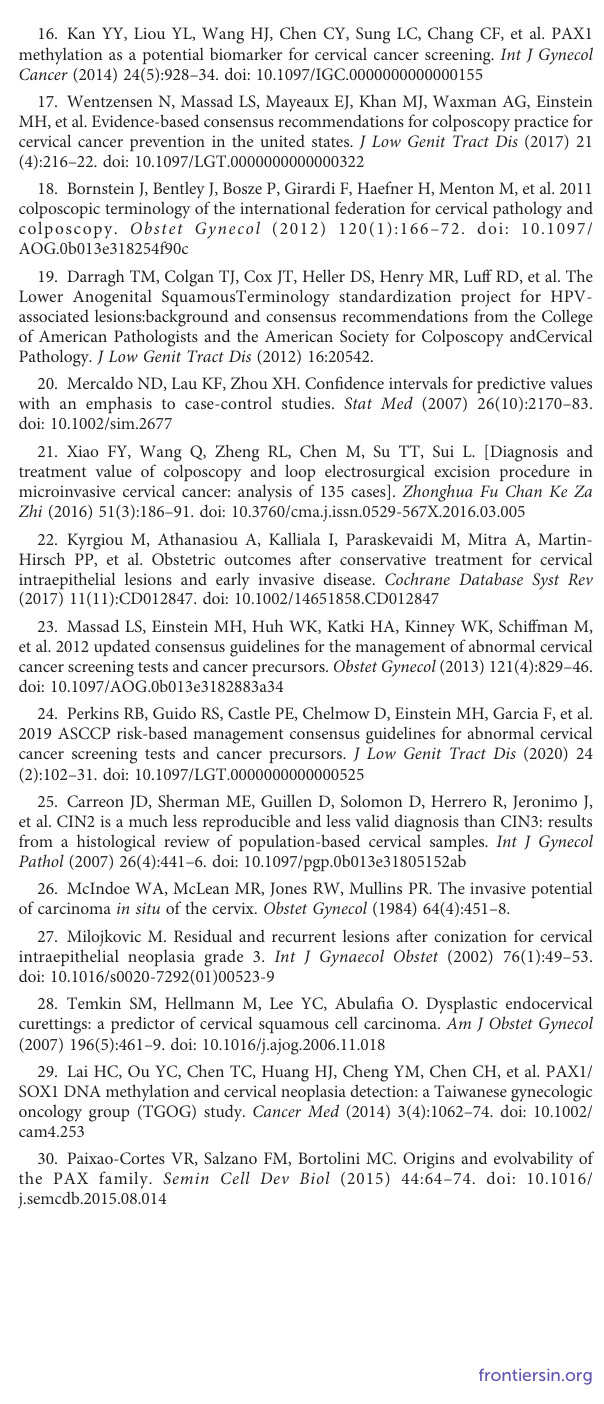
SUPPLEMENTARY FIGURE 1 Restricted cubic splines of odds ratio for CIN3+CKC according to D Cp PAX1 levels in all